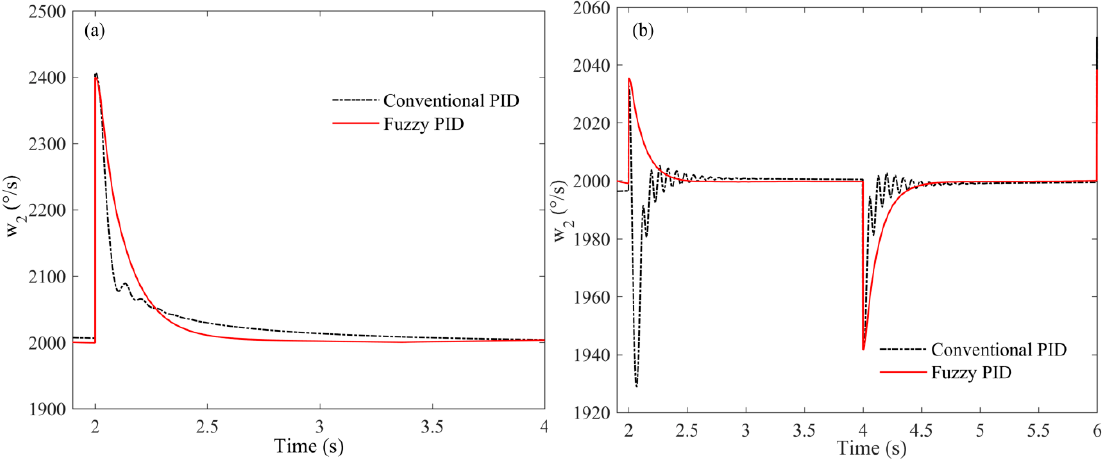
Figure 10. Experimental test effect of the designed fuzzy PID controller on the torsional vibration control of the flexible-joint robot system.